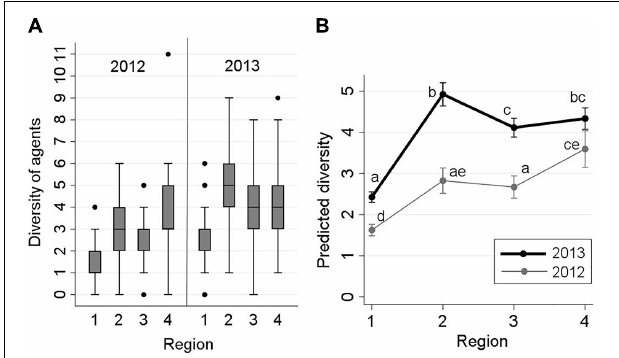
FIGURE 2 | Frequency distribution of the diversity of infectious agents detected in 2,006 Fraser River juvenile Sockeye salmon by sampling region and year (left side: A ), and the interaction plot for the results of the Poisson regression model, indicating predicted number of detected infectious agents ( Y -axis) from fish by sampling region ( X -axis) and year (right side: B ). Sampling regions: (1) Freshwater, (2) Strait of Georgia, (3) Discovery Islands, and (4) Johnstone Strait and north. Statistical comparisons among the predicted diversity of these regions are presented by small letters on the graph (Bonferroni groups). Small letters in (B) represent statistically significant differences (at α = 0.05) between the points (unique combinations of ‘region’ and ‘year’), obtained from pairwise comparisons using Bonferroni adjustments. Points that share, at least, a letter are not statistically different ( P > 0.05), and points with no letters in common have statistically significant differences in the predicted diversity ( P ≤ 0.05).